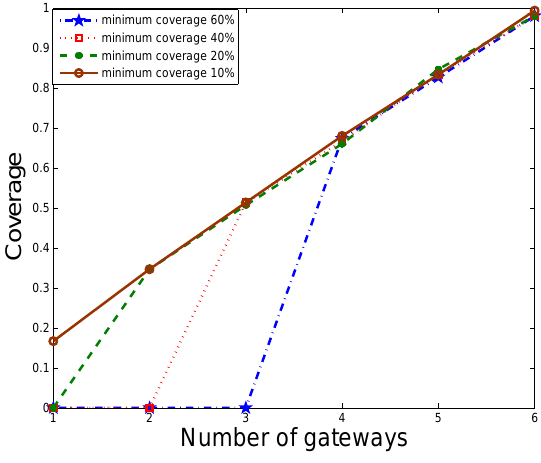
Figure 7. Impact of minimum coverage.